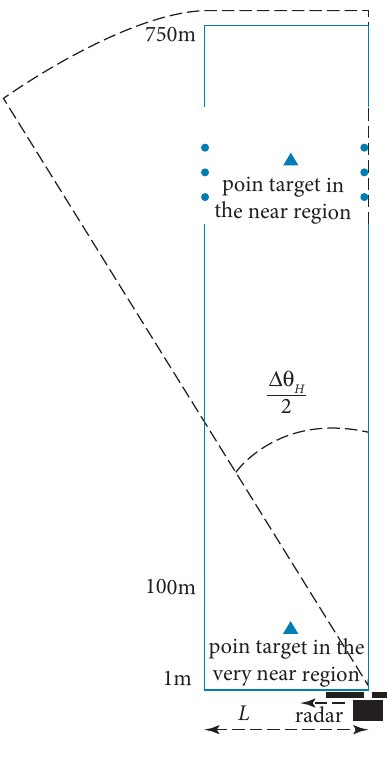
Figure 4. Probing polygon